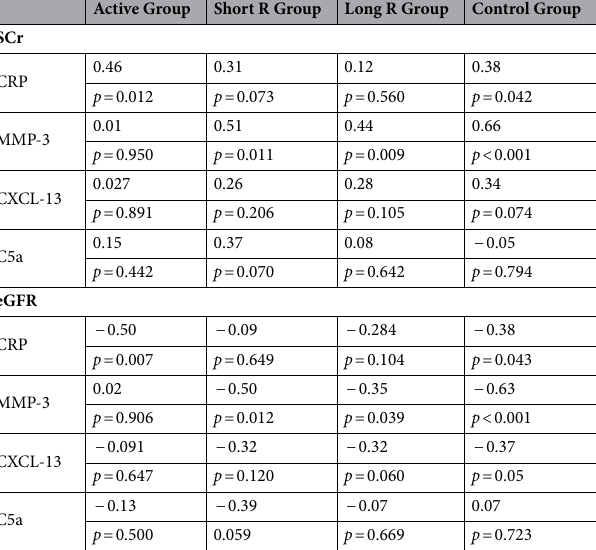
Active Group Short R Group Long R Group Control